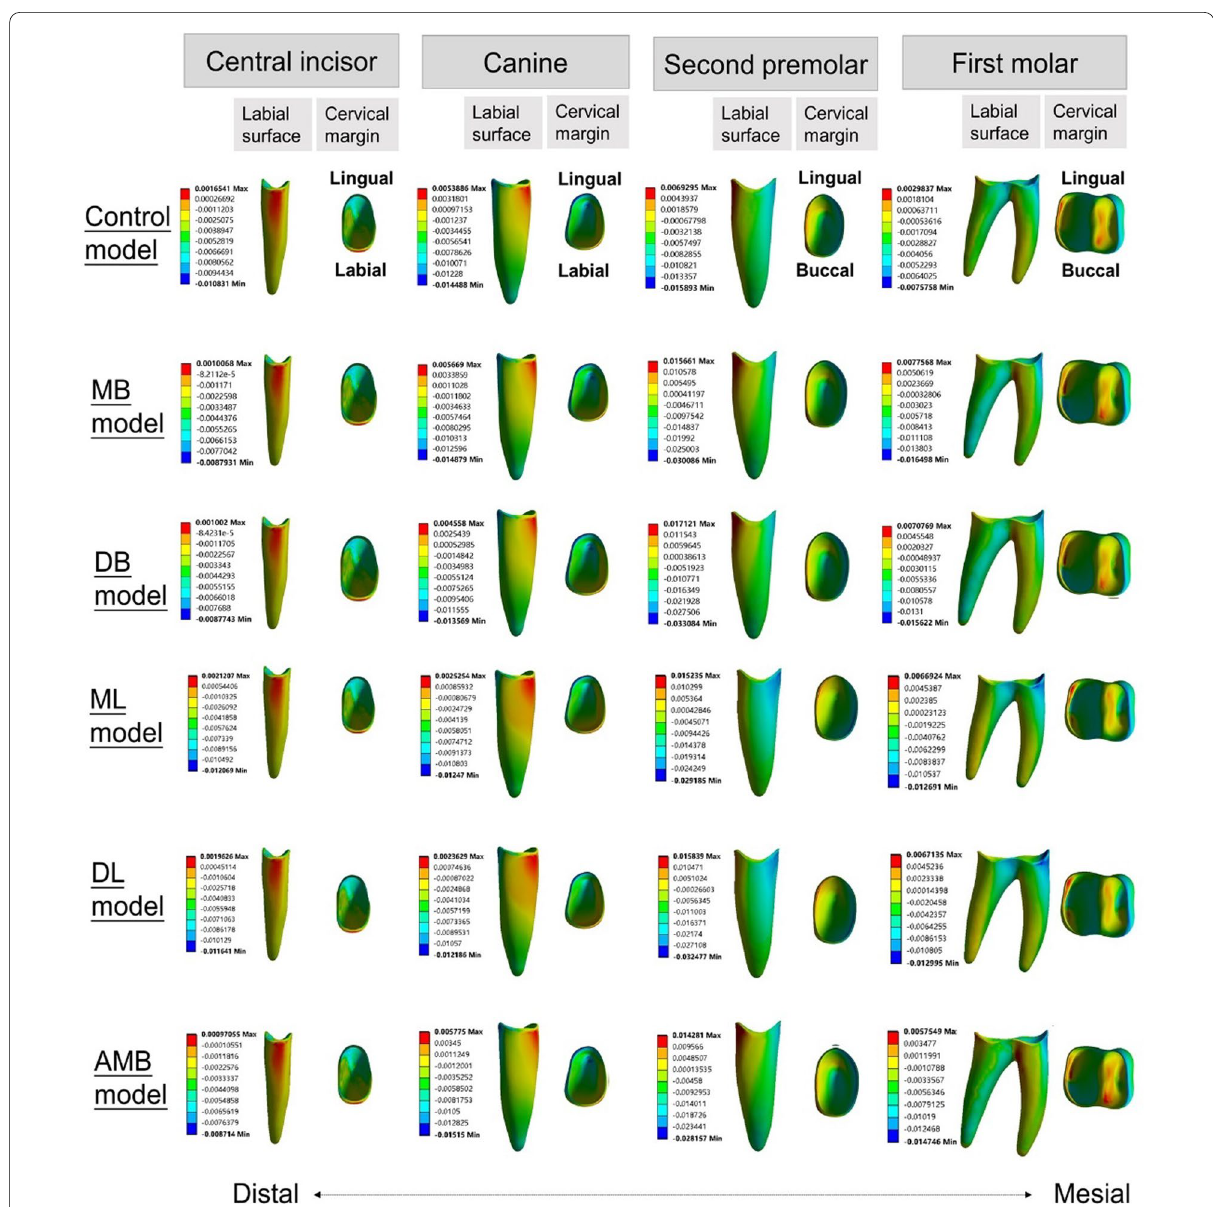
Fig. 9 Minimum principal stress distribution of PDL in six models